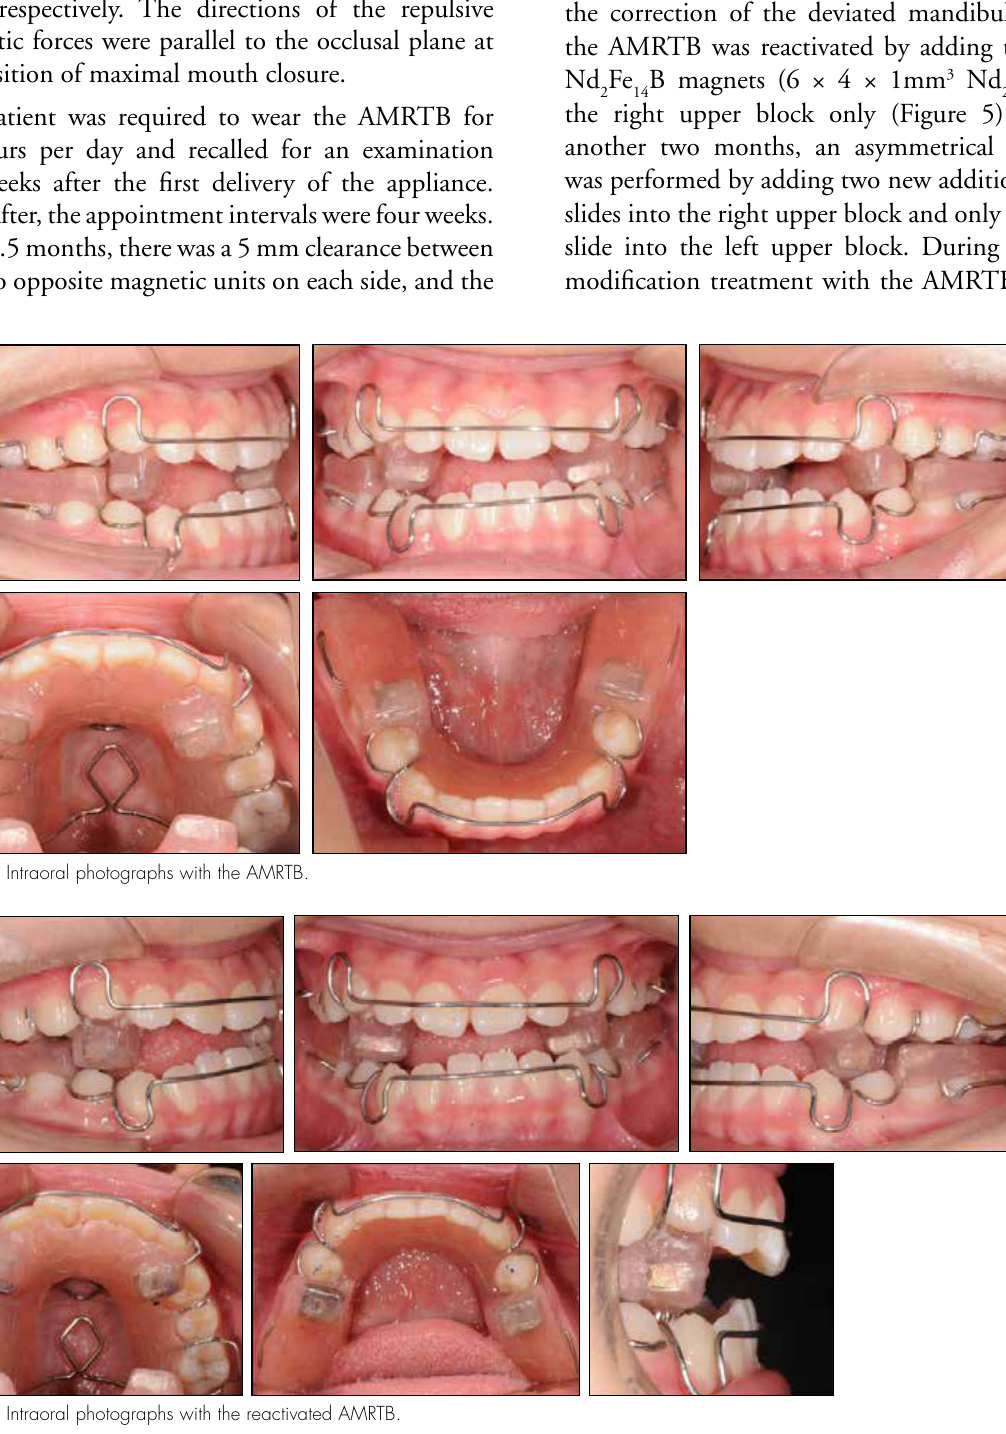
Figure 5. Intraoral photographs with the reactivated AMRTB.